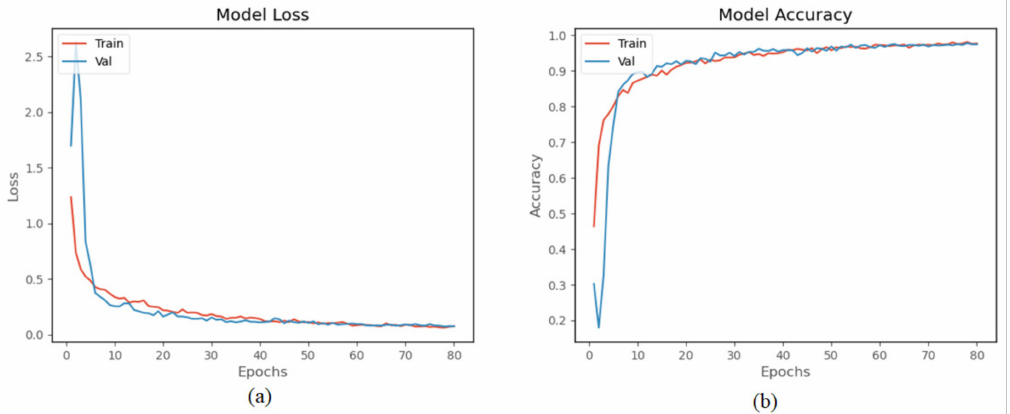
Figure 15. Results of the model on WISDM dataset: ( a ) training loss and validation loss, and ( b ) training accuracy and validation